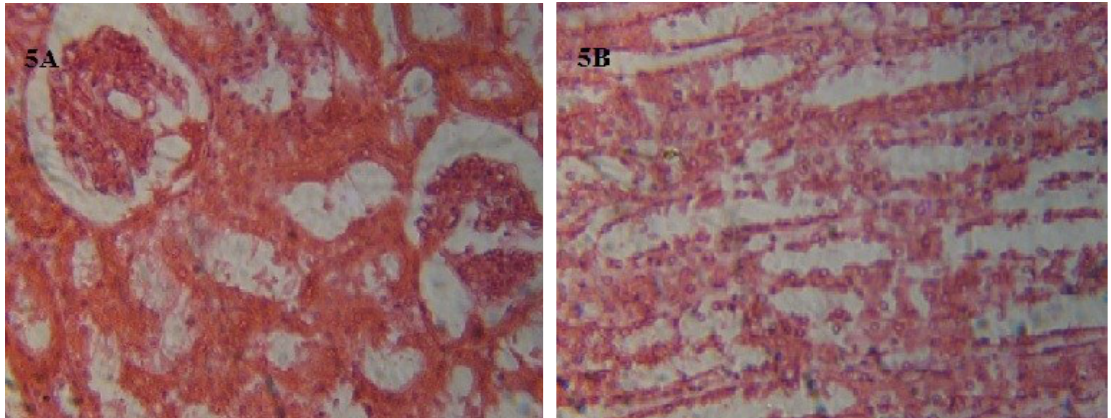
Figure 5: Microphotographs of Group C-ze ( C. zeylanicum treated); (5A) renal cortex presenting no common abnormality and (5B) renal medulla presenting few ruptured